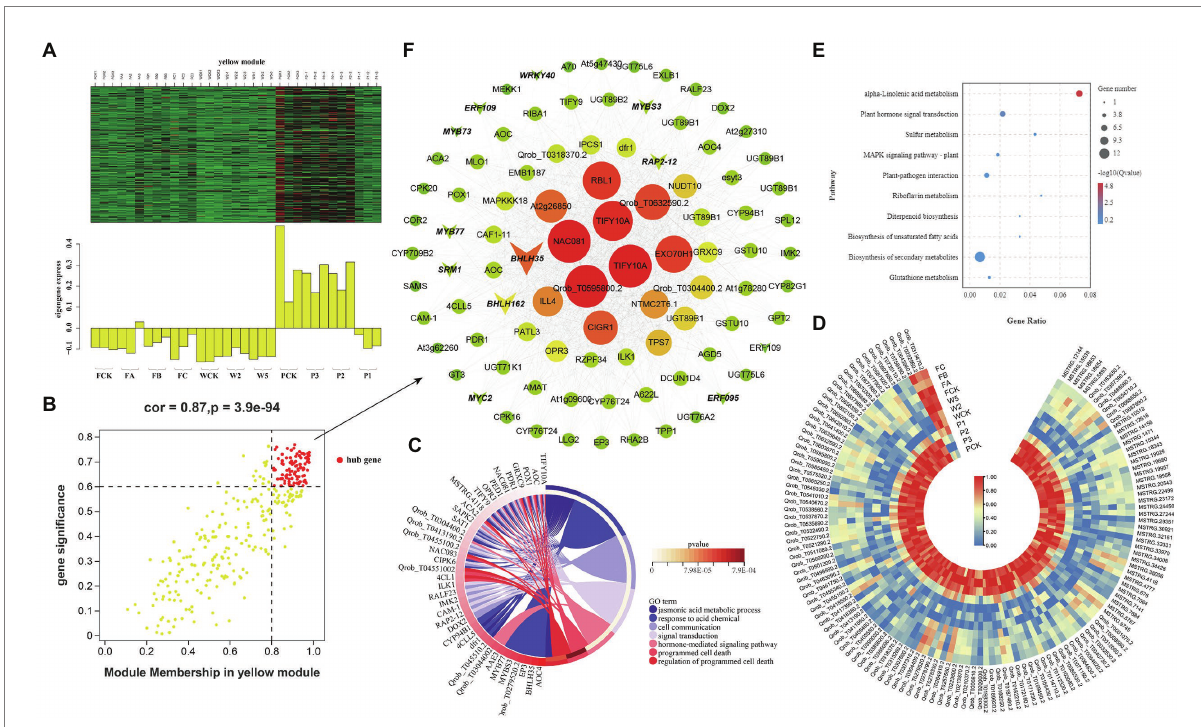
FIGURE 7 Coexpression network of the yellow module. (A) Gene coexpression heat map of the yellow module (upper panel) and expression of the corresponding eigengenes in each sample (lower panel). (B) Soluble sugar and the yellow module have a point map of the hub gene with higher connectivity and expression. The x axis represents the correlation between the expression of each gene and the module, and the y axis represents the correlation between each gene and the trait. (C) GO term enrichment analysis cycle of hub genes associated with soluble sugar traits in the module. (D) Heat map of hub gene expression associated with soluble sugar traits. (E) KEGG enrichment bubbles are associated with soluble sugars. (F) Coexpression network of hub genes in the yellow module. The first 100 hub genes with a weight value >0.30 and higher expression were used to construct the